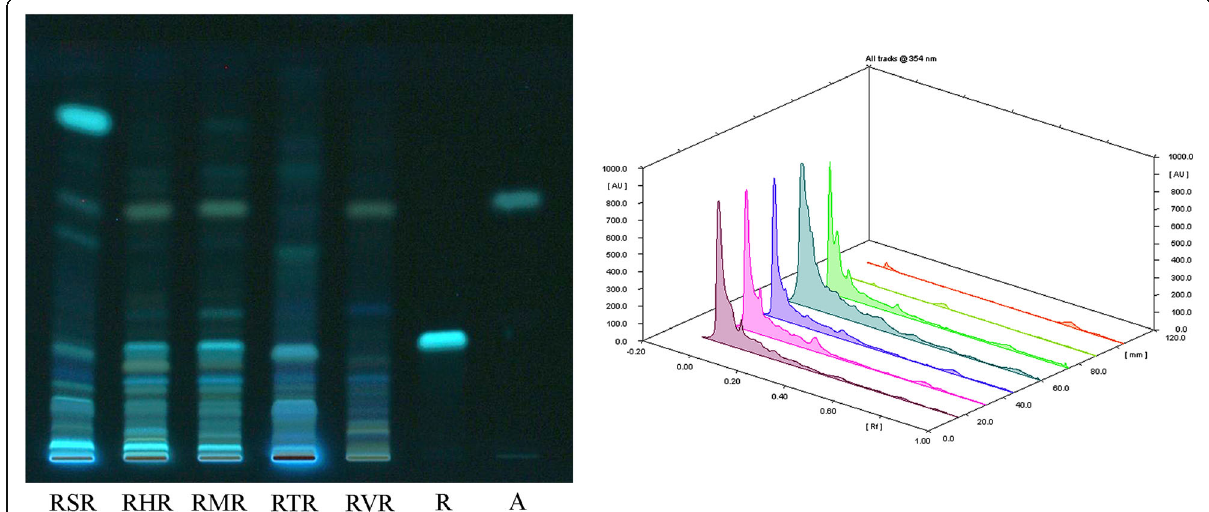
Fig. 5 HPTLC profiling of alkaloid fractions of selected Rauvolfia species with marker compounds. RSR: R. serpentina root, RHR: R. hookeri root, RMR: R. micrantha root, RTR: R. tetraphylla root, RVR: R. verticillata root, R: Reserpine, A: